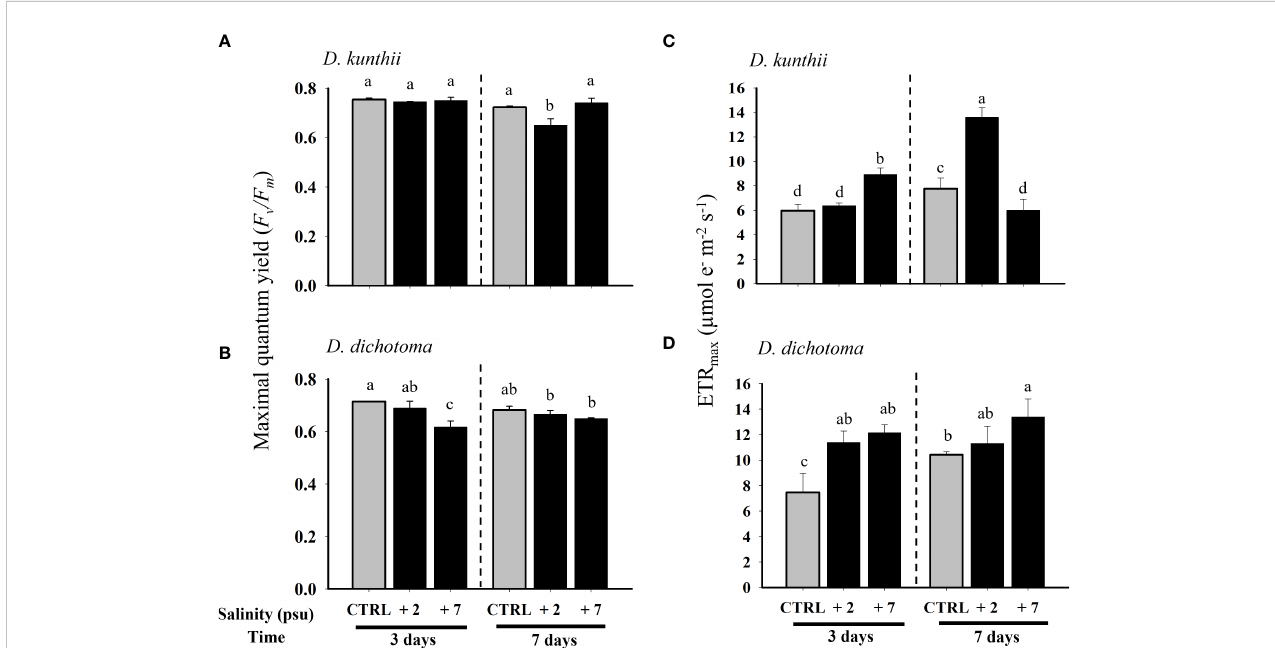
FIGURE 1 Maximal quantum yield ( F v /F m ) and maximum electron transport rate (ETR max ) in D. kunthii (A, C) and D. dichotoma (B, D) exposed to high salinity values. For D. kunthii , the salinity values were 35 psu (control), 37 (+2) psu, and 42 (+7) psu; for D. dichotoma , these were 37 psu (control), 39 (+2) psu, and 44 (+7) psu. The samples were analyzed after 3 and 7 days. Data corresponds to mean ± SD ( n = 3). Letters represent statistical difference at 95% con fi dence interval (Student – Newman – Keuls test, p <